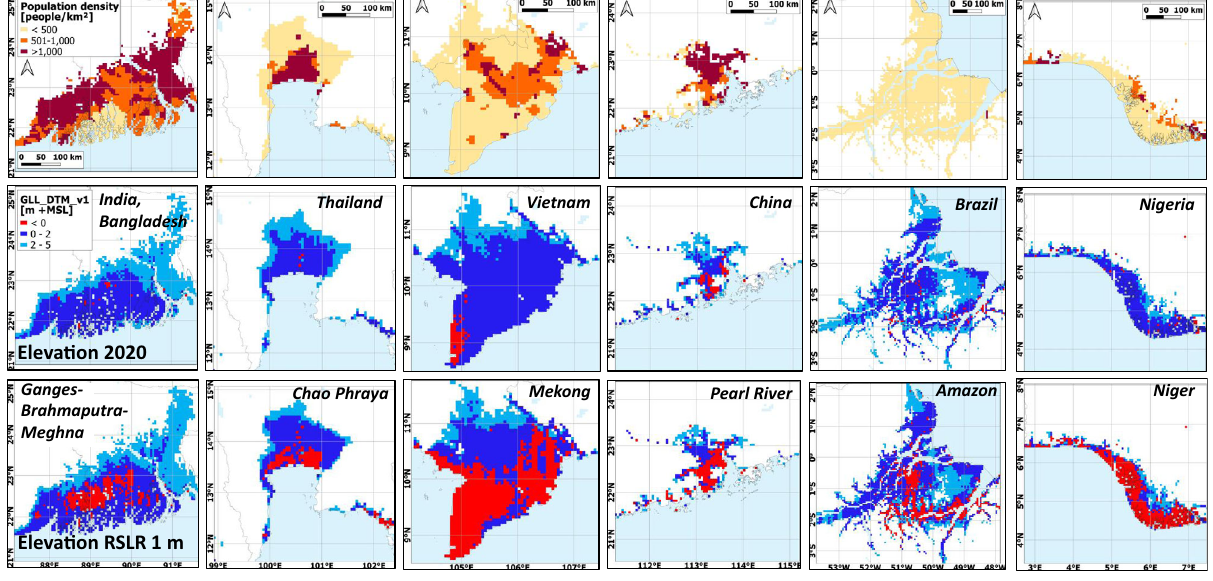
Fig. 4 Population and land surface elevation below 5 m above mean sea level ( + MSL) for 6 selected large tropical deltas. (Top) Population in 2020 (middle) land surface elevation in 2020 and (bottom) land surface elevation after 1 m relative sea-level rise